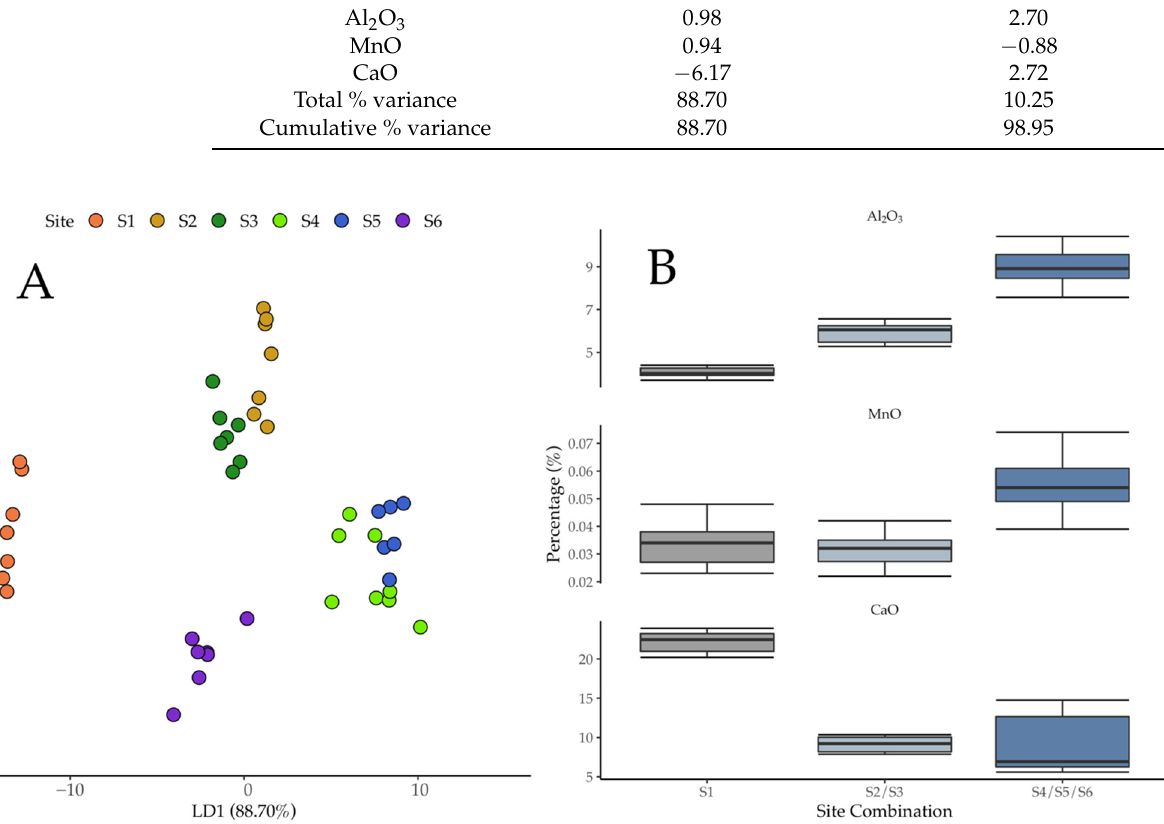
Figure 4. ( A ) Linear discriminant analysis (LDA) of sampling sites based on centered and scaled (to have equal weighting of variables) geochemical composition (Al 2 O 3 , MnO, CaO) of stored riverbed sediment, and ( B ) boxplots of geochemical variables used in LDA across site combinations (S1, upstream, downstream). Horizontal lines indicate the median, boxes indicate lower/upper quartiles. Error bars indicate 1.5 times the inter-quartile range or the minimum/maximum value observed, whichever is smaller.